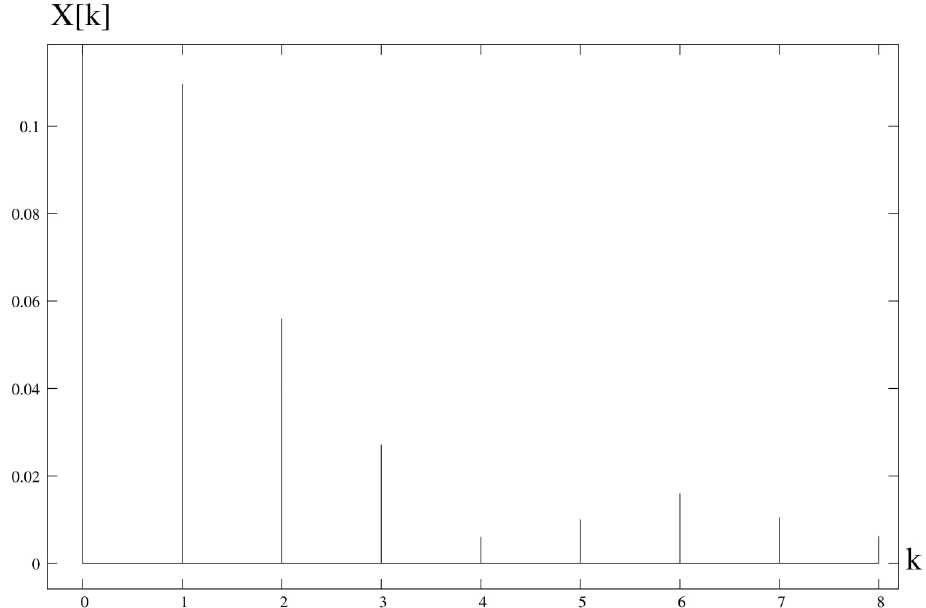
Figure 5. Harmonics of the amplitude spectrum for Da = 0.13 and τ r = 6.5.